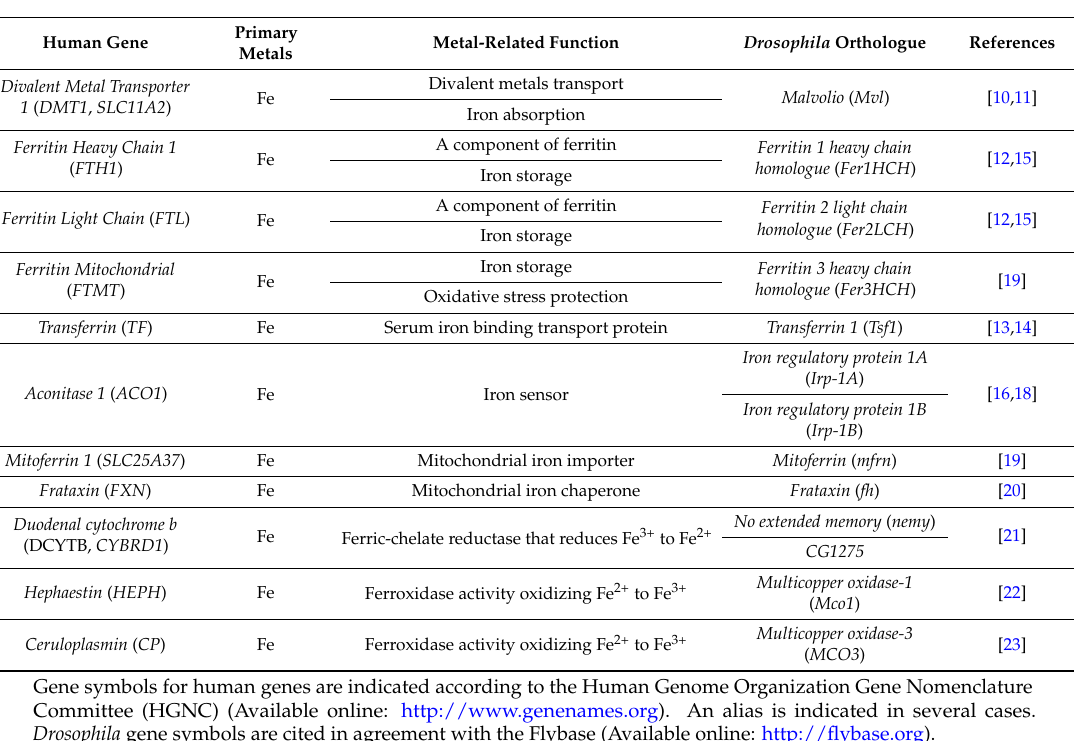
Table 1. Conserved proteins in iron homeostasis.